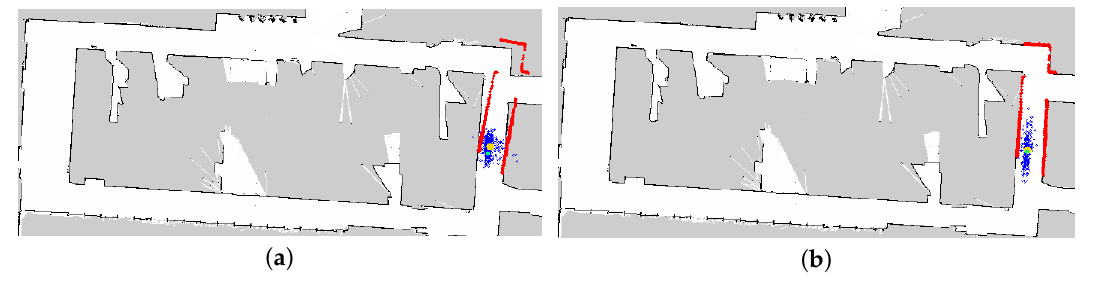
Figure 11. Self-correction of local pose tracking. ( a ) The position deviated when the robot rotated. ( b ) The robot corrected the pose automatically with HPFL.